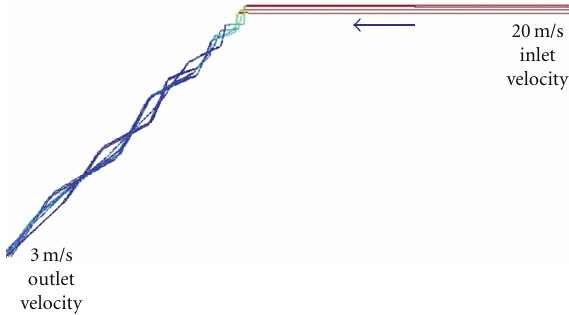
Figure 14: Particle tracks, with entrance and exit velocities, in 45 degree elbow. Outline of elbow is not shown in order to better show particle